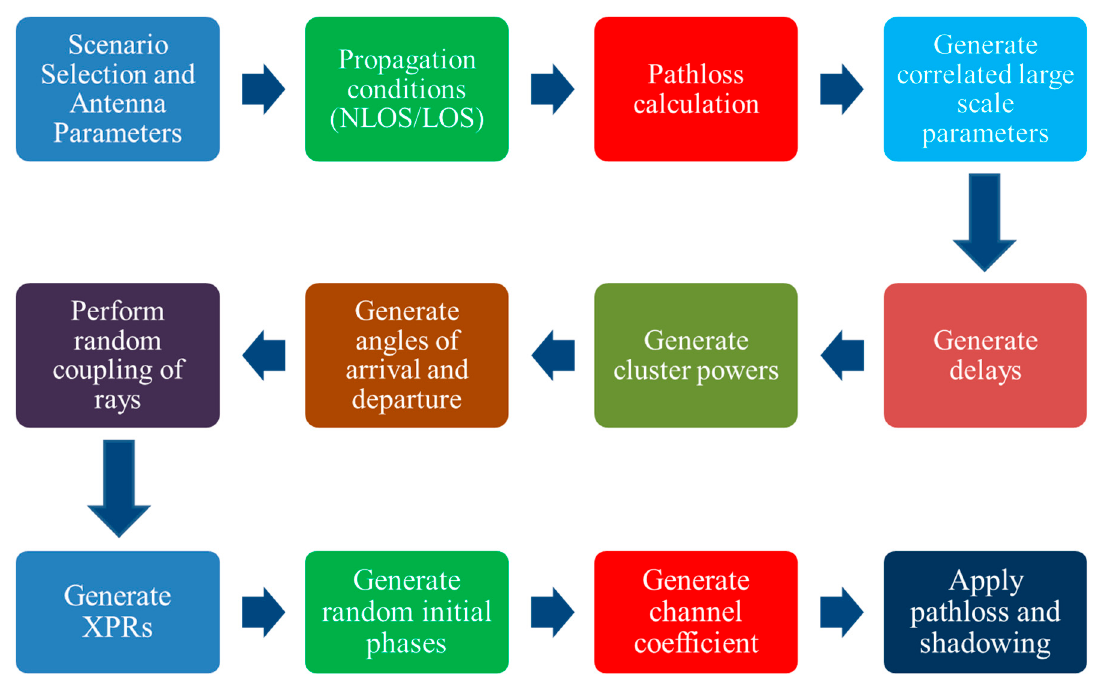
Figure 3. Channel modeling for wireless 5G cellular